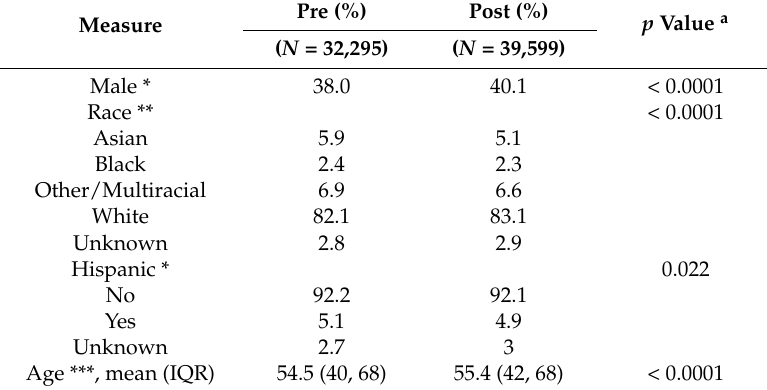
Table 2. Demographics of patients with PC visits pre- and post-implementation of Behavioral Health Integration including the Program of Sustained Patient-centered Alcohol-related Care (SPARC). Pre (%) Measure